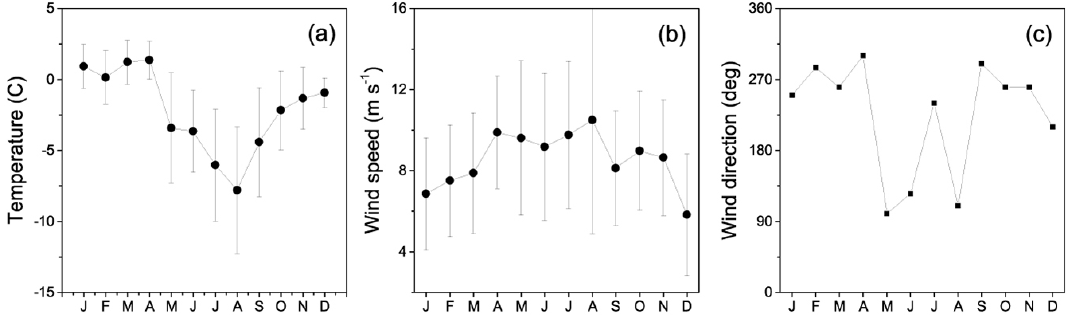
Figure 3. The 2013 Climate statistics for KSG: (a) mean monthly temperature, (b) mean monthly wind speed and (c) median monthly wind direction; whiskers represent ± 1 σ of hourly